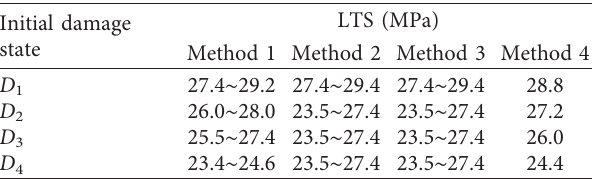
Figure 9: Relationship between the LTS and the initial damage of rock. Table 4: LTS of rock with different initial damage obtained by four methods.